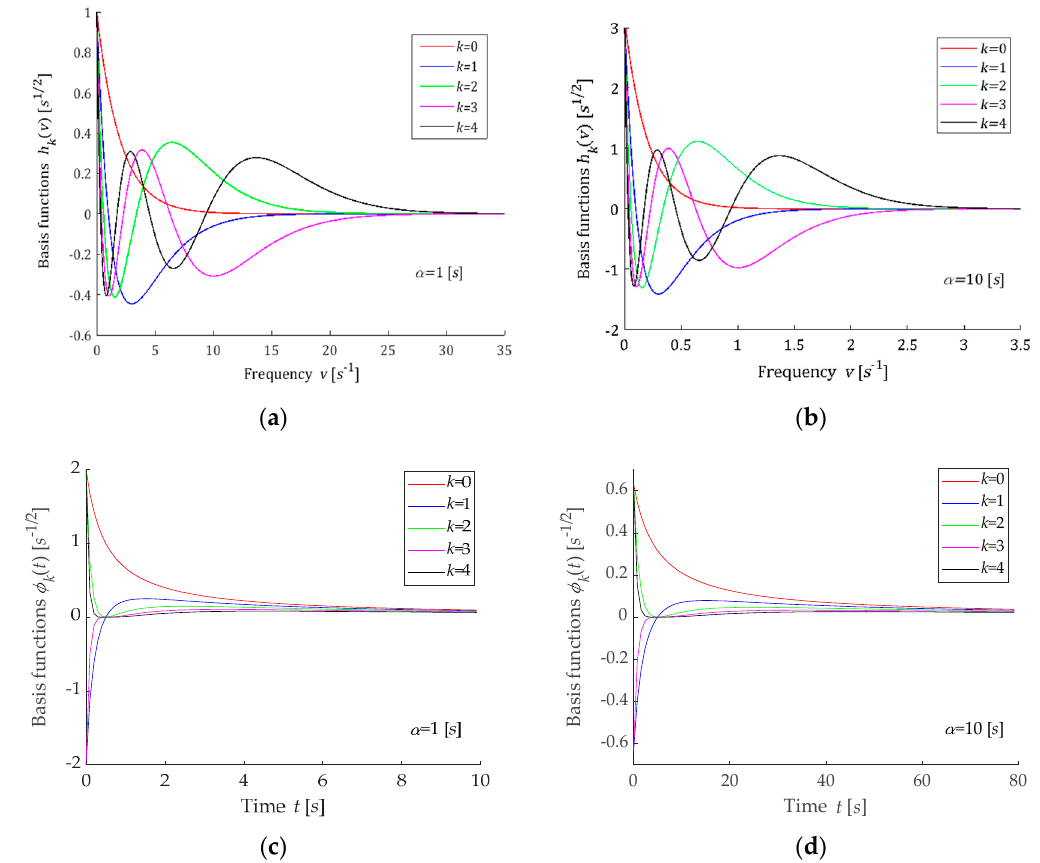
Figure 2. Basis functions h k ( v ) (34) and φ k ( t ) (35) of the Laguerre model for two time-scaling factors: ( a ) h k ( v ) , α = 1 [ s ] ; ( b ) h k ( v ) , α = 10 [ s ] ; ( c ) φ k ( t ) , α = 1 [ s ] ; ( d ) φ k ( t ) , α = 10 [ s ] ; k = 0,1,2,3,4 .